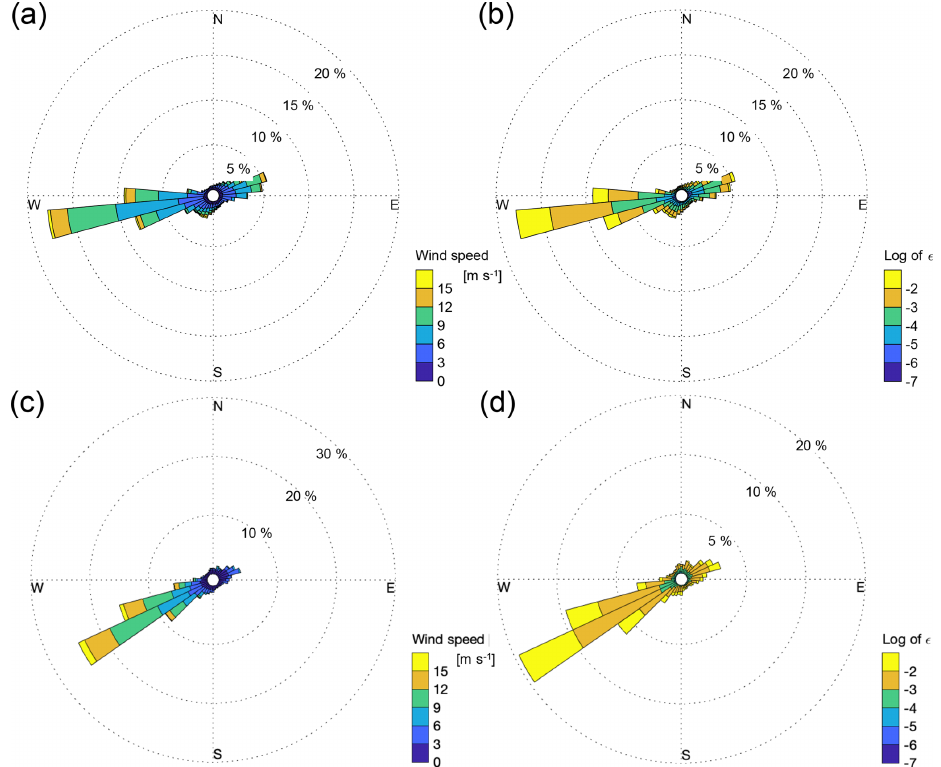
Figure 9. Wind roses at 100ma.g.l. from the WINDCUBE v2 at Gordon Ridge (a) and the Halo Streamline at Boardman (c) and the correspondent turbulence dissipation roses at the same altitude (b, d)